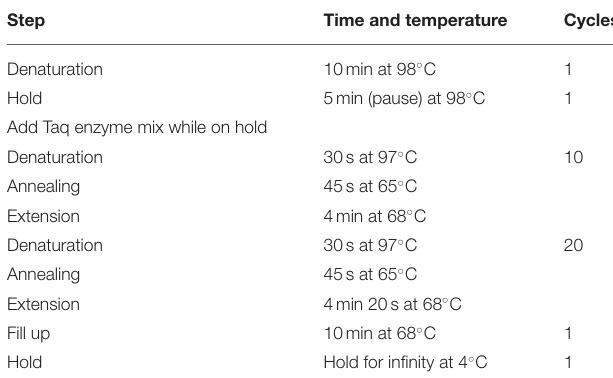
TABLE 1 | Endpoint PCR program for fragile X syndrome.